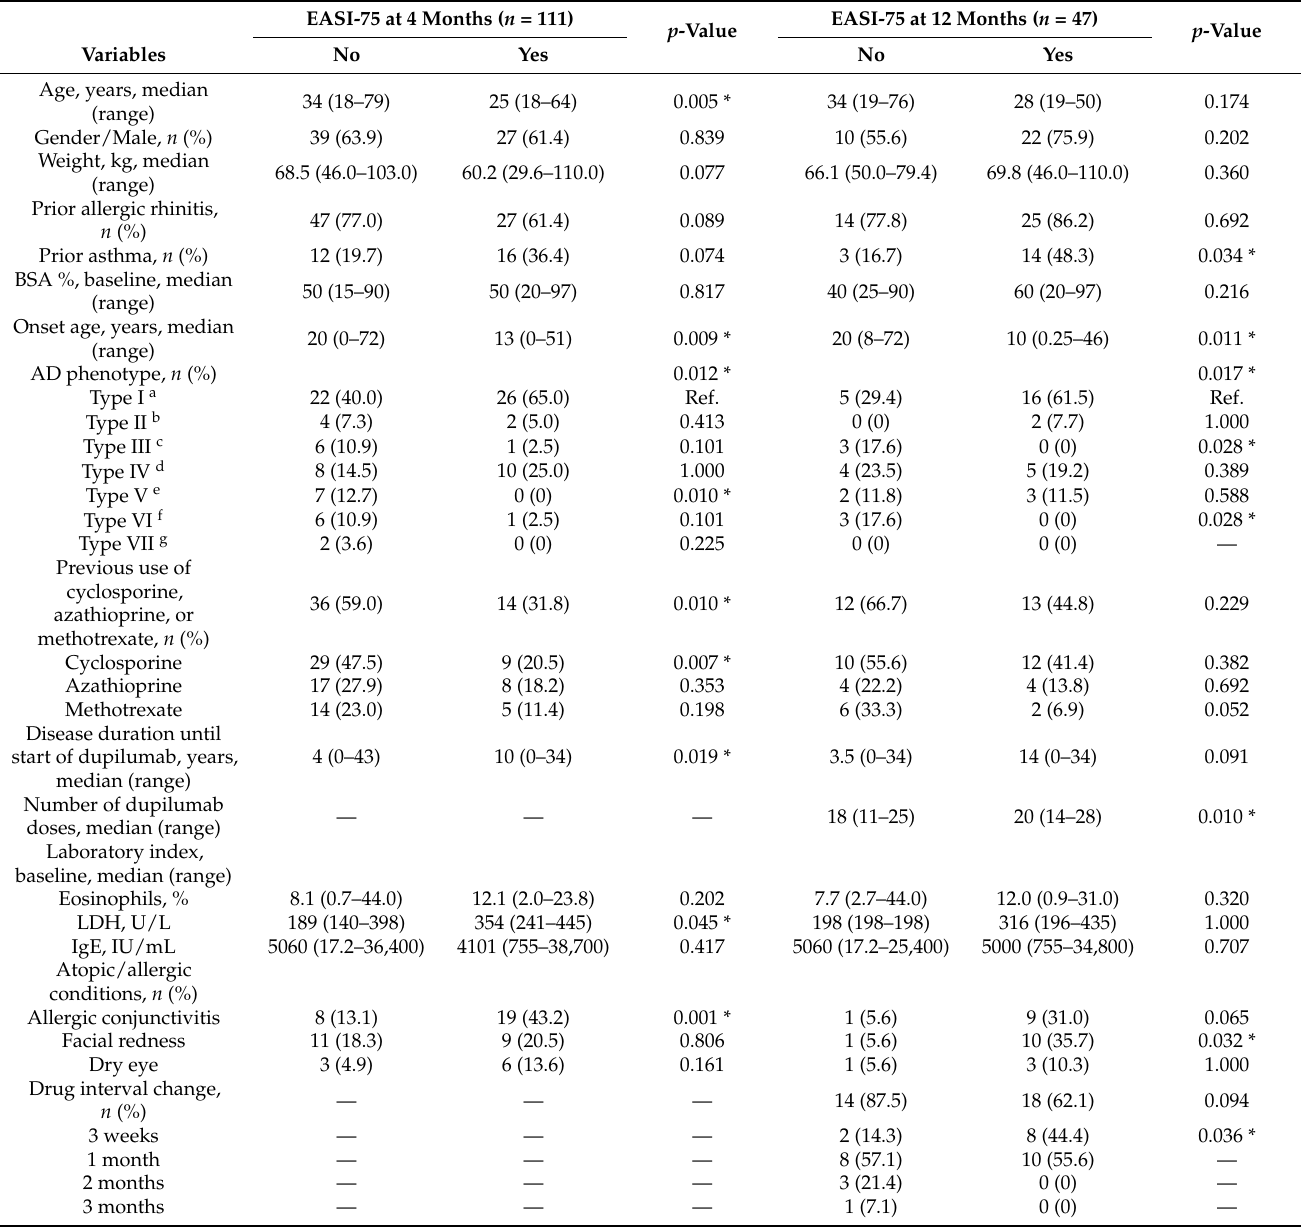
Table 3. Associations between patients’ characteristics and